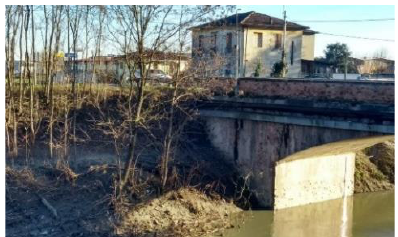
Figure 3. Survey site conditions in the preliminary inspection.